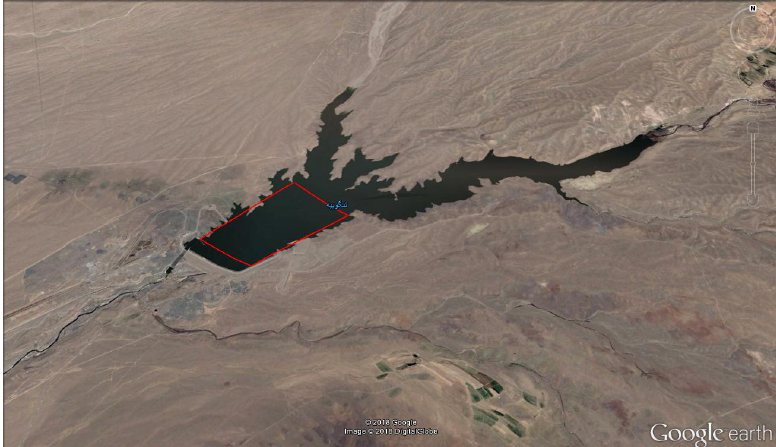
Figure 5. the image of Tanguie dam from google earth Dam’s total surface area is about 2 km 2 and its total volume is about 38.5 million m 3 . Figure 5 shows the image of Tanguie dam from google earth. In order to prevent input and output water turbulence, a part of dam is selected to install solar panels. The area of this part is 678628 m 2 . For each two rows of panels, one row with about 1m wide is considered for maintenance as shown